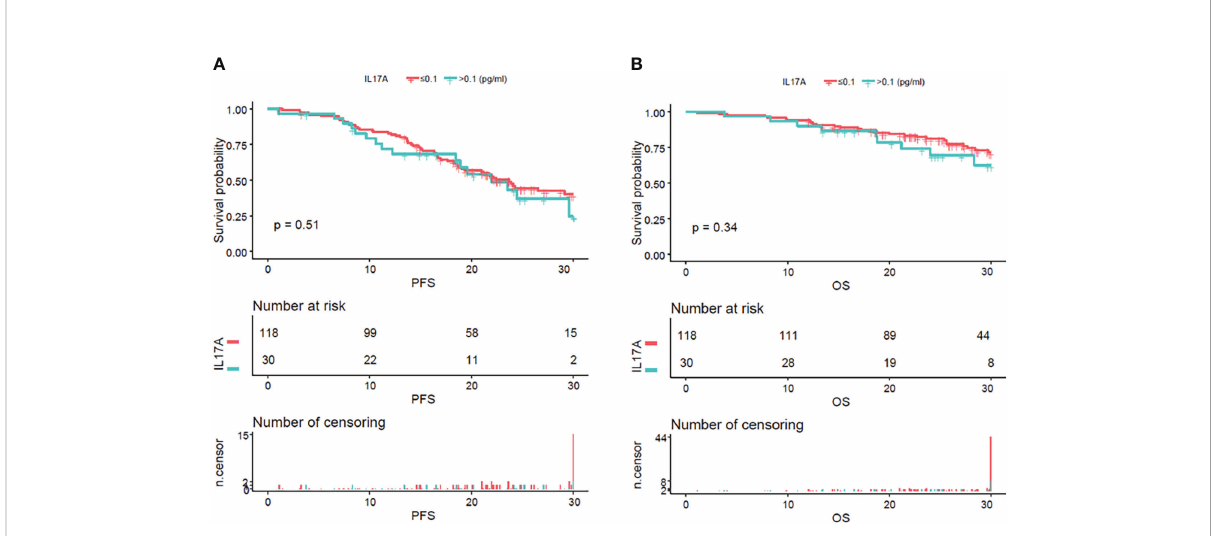
FIGURE 4 Kaplan – Meier curves of progression-free survival (PFS) and overall survival (OS) according to mean serum IL-17A levels. There were no obvious difference in PFS (A) (p = 0.51) and OS (B) (p = 0.34) between the patients with serum IL-17A ≥ 0.1 pg/ml and IL-17A <0.1